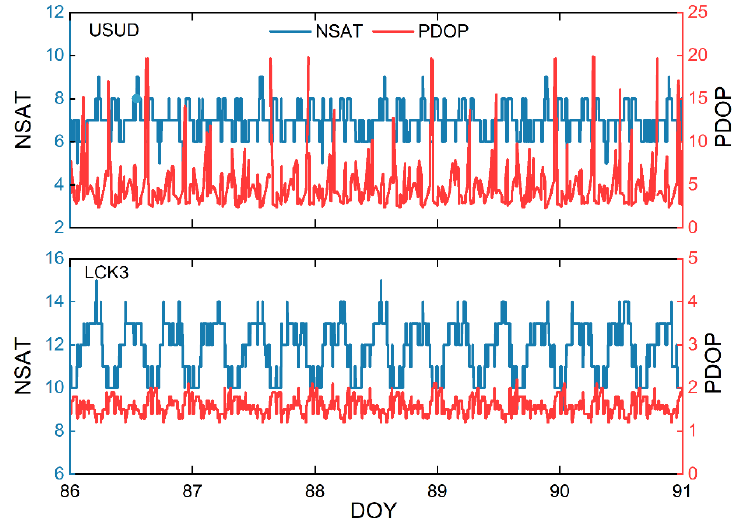
Figure 6. NSAT and PDOP of USUD and LCK3